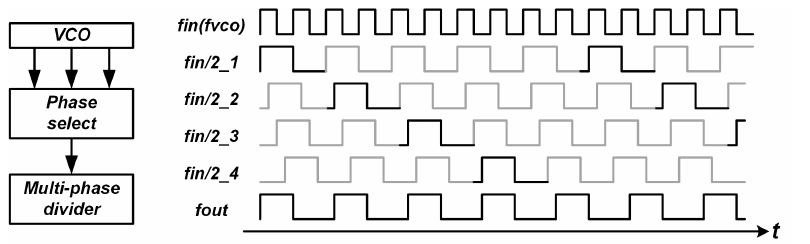
Figure 2. Basic principle of phase